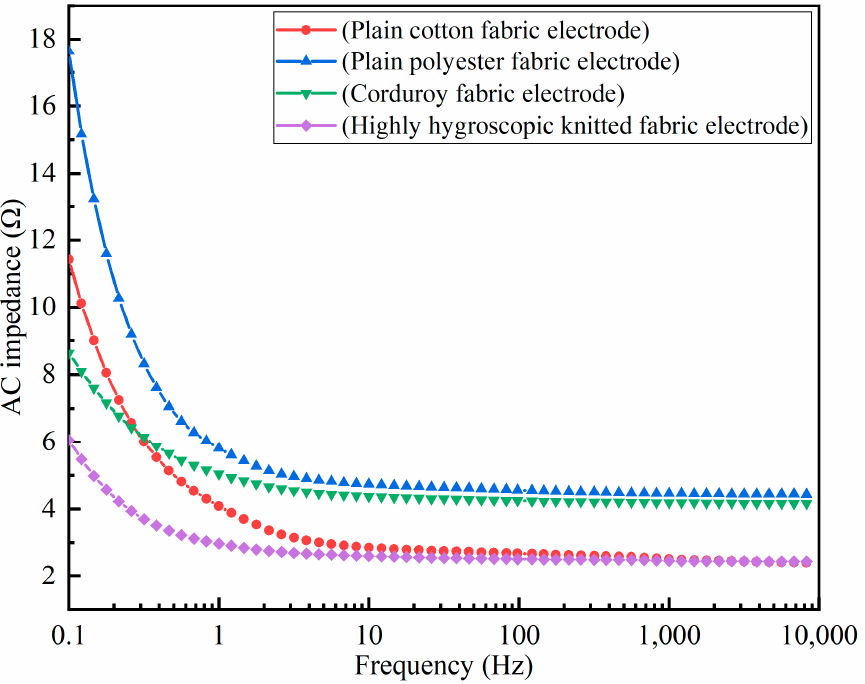
Figure 6. Electrochemical impedance spectra of four fabric electrodes.